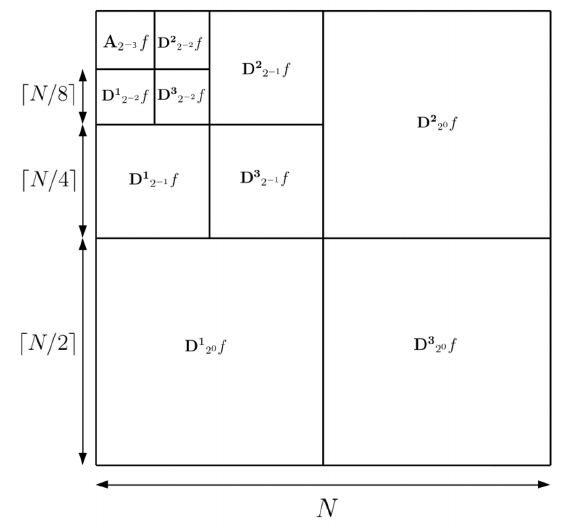
Figure 6. Illustration of the 2D wavelet decomposition of a pattern of size N for three iterations, according to Mallat’s